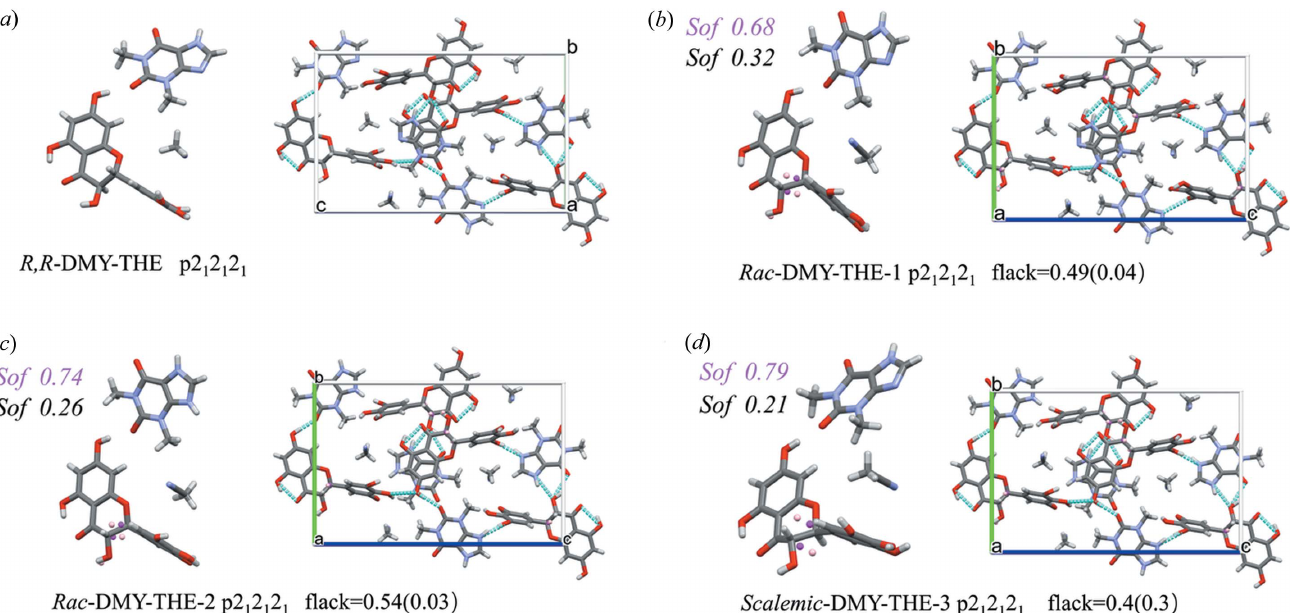
Figure 7 Asymmetric units and unit cells of R , R -DMY–THE ( P 2 1 2 1 2 1 , Z 0 = 1, Z 00 = 3), Rac -DMY–THE ( P 2 1 2 1 2 1 , Z 0 = 1, Z 00 = 3) and Scalemic -DMY–THE ( P 2